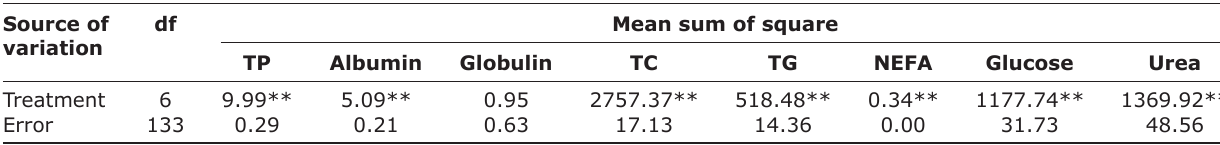
Table-4: Analysis of variance for biochemical metabolites. Source of df Mean sum of variation